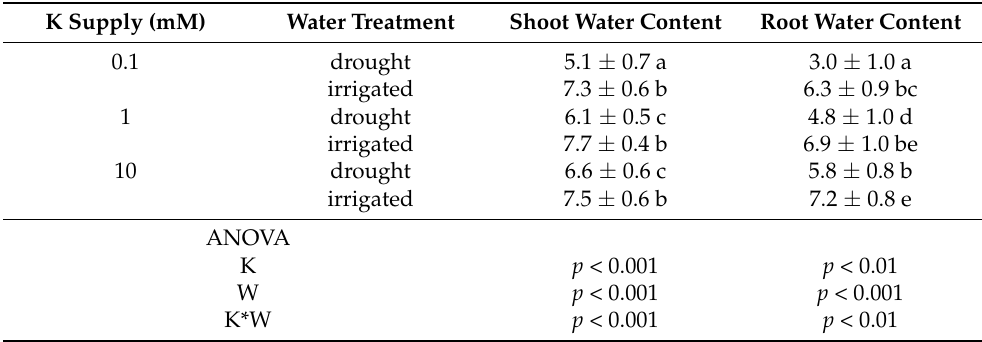
Table 5. Effect of K supply and watering on shoot and root water content (g H 2 O g dry weight − 1 ) in tomato at harvest. Control plants (irrigated) were compared to plants submitted to six cycles of drying/watering after flower initiation (drought). Means followed by the same letter are not significantly different (LSD Test, p < 0.05). K and W in ANOVA represent potassium and water factors,